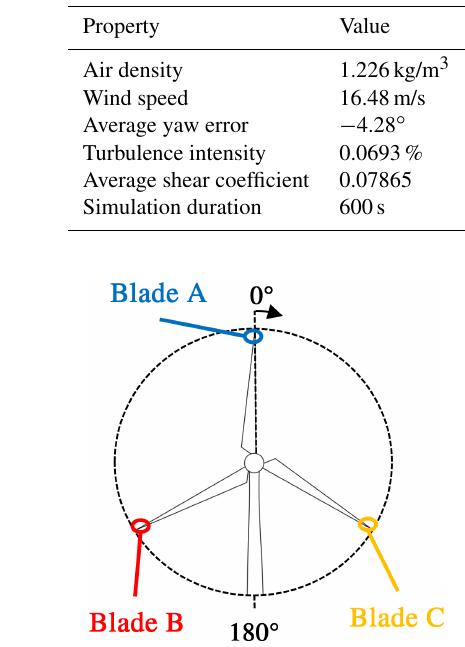
Figure 13. Definition of azimuth angle.